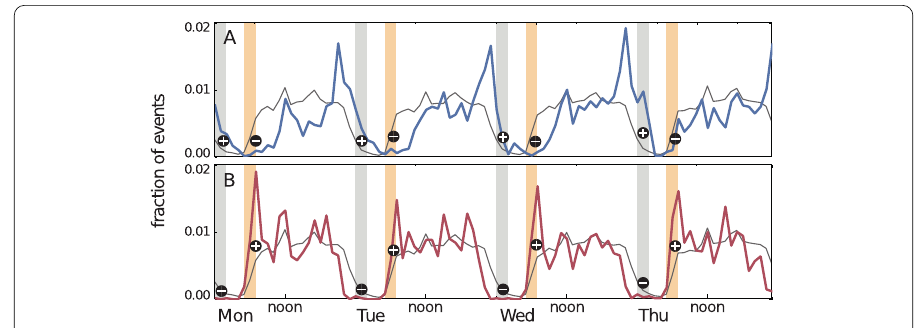
Figure 1 Identifying individuals’ chronotypes. The chronotypes of participants are determined by computing the average hourly frequencies of the “screen-on” events of their mobile phones for the first four weekdays. Each participant’s pattern is compared to the population average (solid gray line). For chronotype identification, the gray and yellow time ranges are used. If a participant has above-average levels of activity (plus sign) in the night-time gray time range and below-average levels of activity (minus sign) in the yellow morning time range, she is categorized as an evening-active owl (panel ( A )). Participants of the opposite pattern (below-average night-time activity and above-average morning activity) are categorized as morning-active larks (panel ( B ) depicts the pattern for a morning-active person). For details, see Materials and